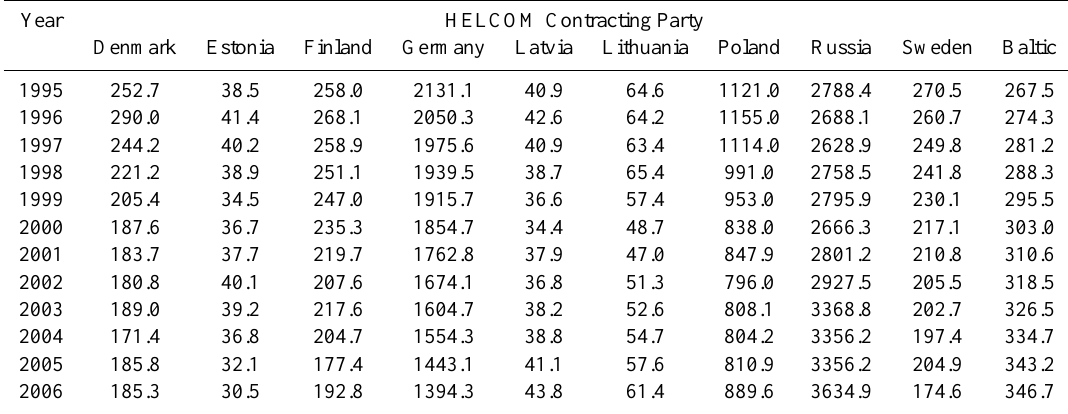
Table 1. Annual emissions of nitrogen oxides in HELCOM Contracting Parties and from the international ship traffic on the Baltic Sea in the period 1995–2006. Units: GgNO 2 per year.